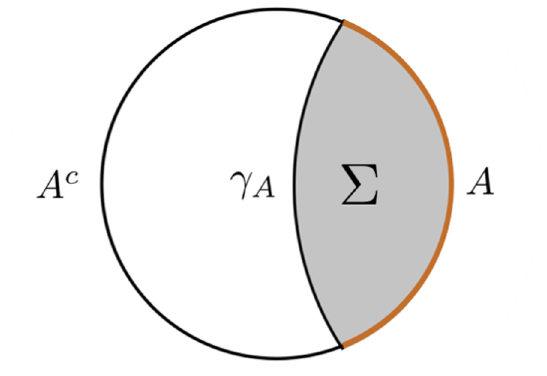
Figure 2. Here the disk represents a spatial slice of AdS. For a state associated with the boundary subregion A (represented by the brown segment), its entropy is equal to the area of the minimal surface anchored to ∂A . Here it is given by the minimal geodesic γ A . The shaded region Σ that is bounded by A and γ A is also defined as the entanglement wedge of A